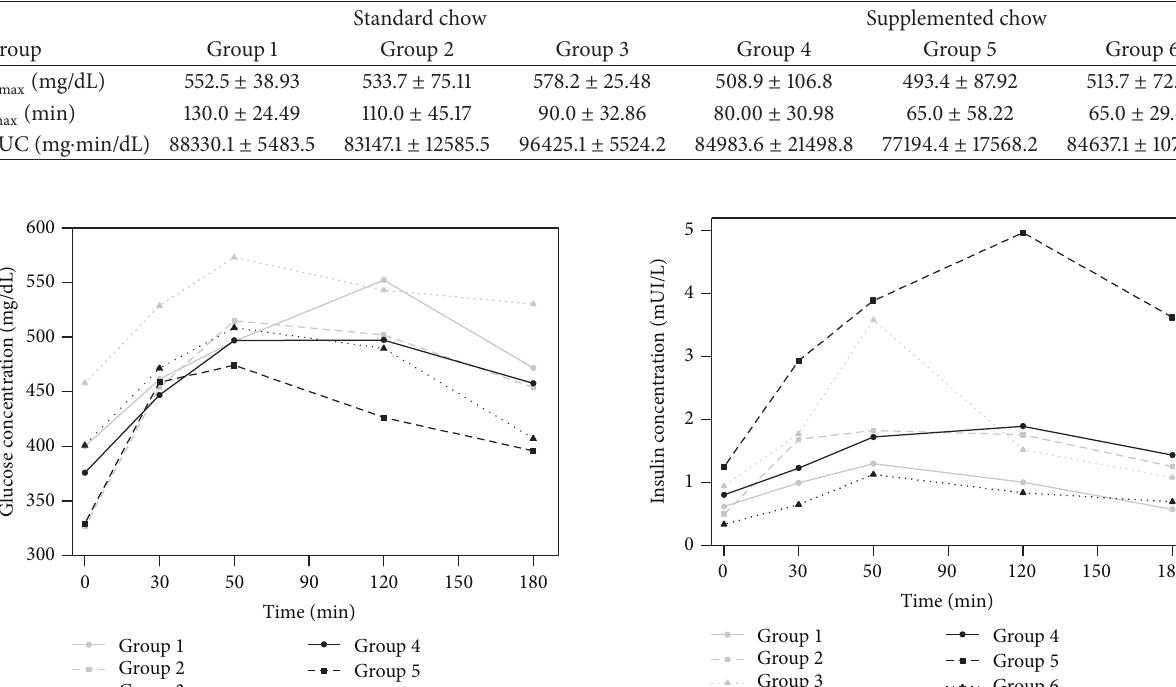
Table 1: Pharmacokinetic parameters obtained for glucose after the administration of an oral 3 g glucose load in the 6 groups after study. Group 1: control standard; group 2: oral metformin; group 3: oral metformin with Plantago ovata husk; group 4: control supplemented; group